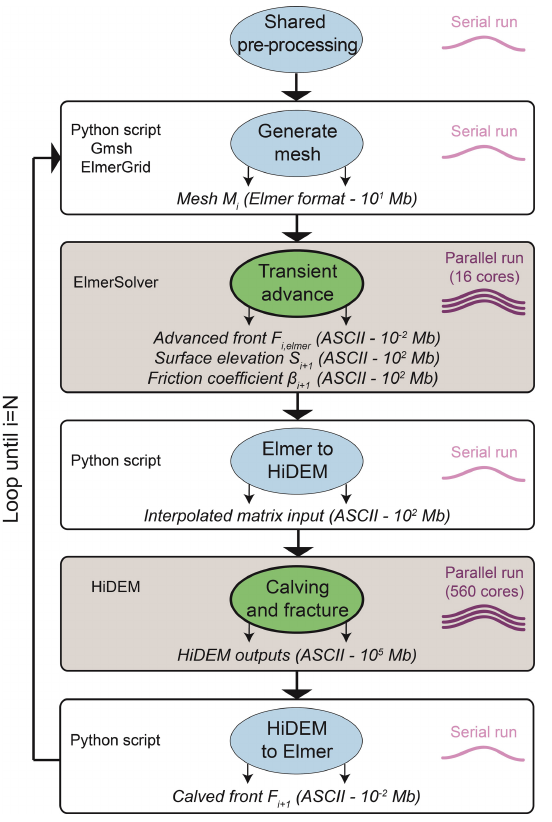
Figure 2. Generic workflow layout with blocks representing steps.